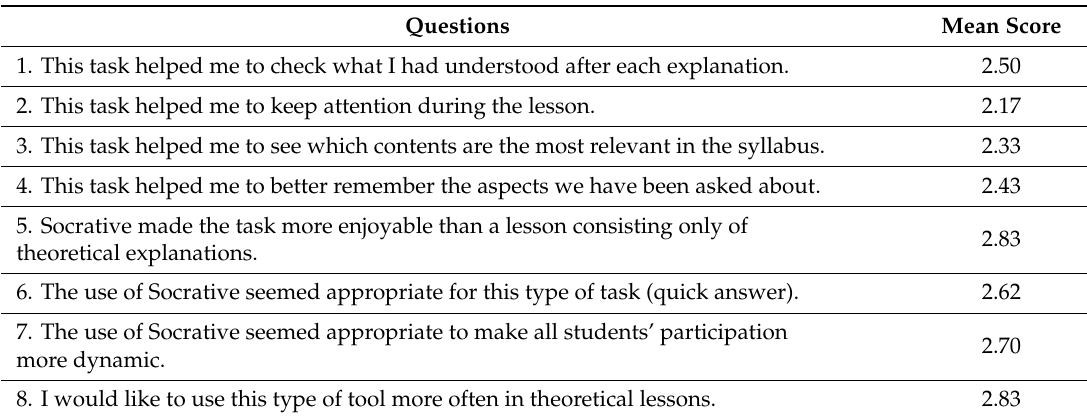
Table 3. Lecture: Questions and mean scores.